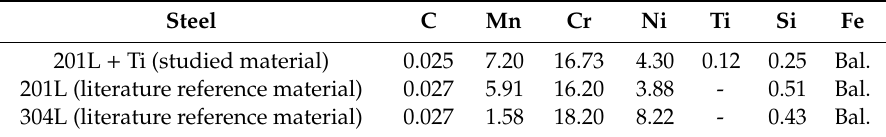
Table 1. Chemical compositions (in wt.%) of Ti-bearing 201L, 201L and 304L stainless steels. Steel C Mn Cr Ni Ti Si Fe 201L + Ti (studied